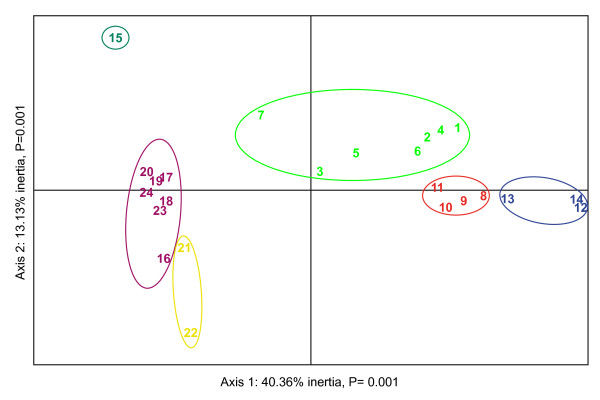
Principal component analysis based on pairwise FST over all populations. Both axes are significant (P < 0.001). Samples are encoded as in Table 1. Colored ellipsoids correspond to clusters shown in Figure 1b and were only drawn for better visualization.